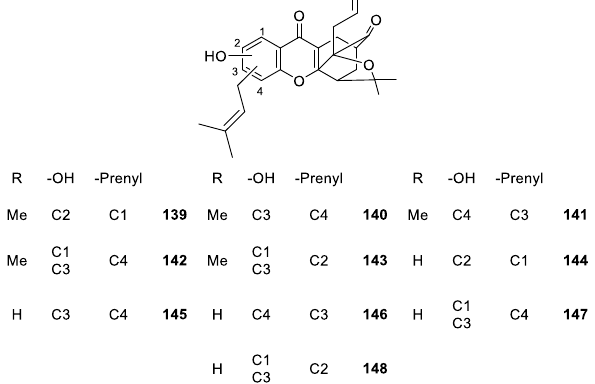
Figure 13. Structures of caged xanthones 139 – 148 , with antitumor activity.